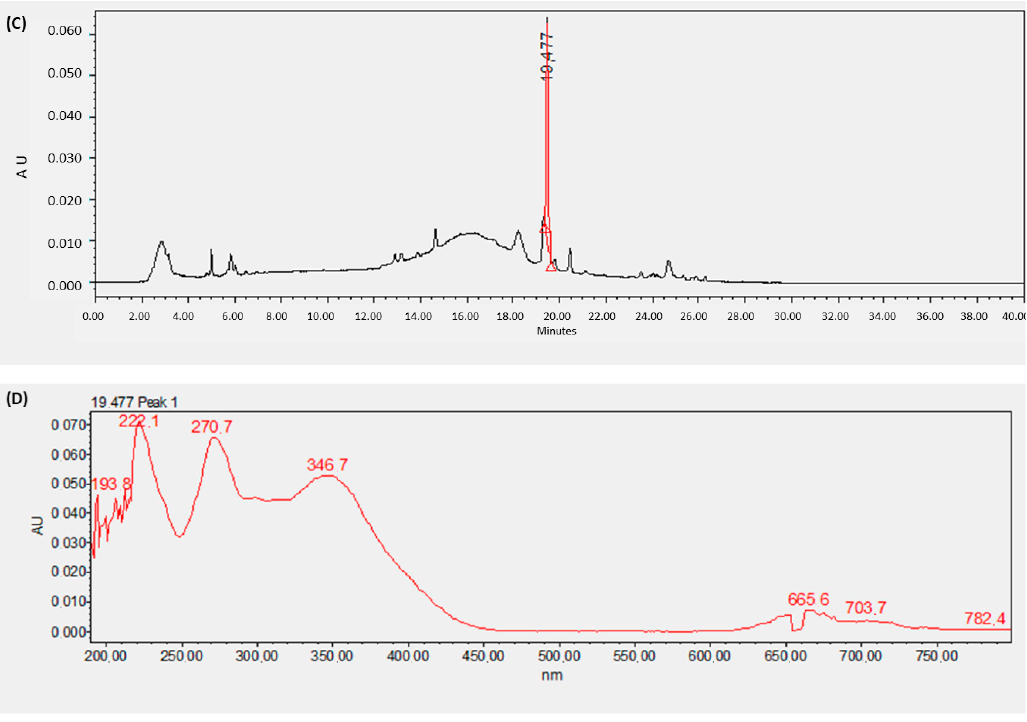
Figure 6. Ultra high-performance liquid chromatography (UPLC) chromatograms of M. albida extract ( A ) and Ma AgNPs synthesized with it ( C ). UV-Vis spectra are shown for the main components of the extract ( B ) and Ma AgNPs ( D ).